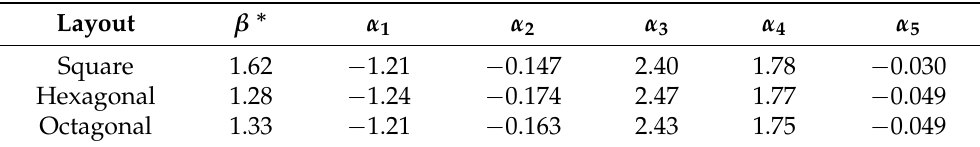
Table 1. Coefficients for Data Fitted Monomial formula.